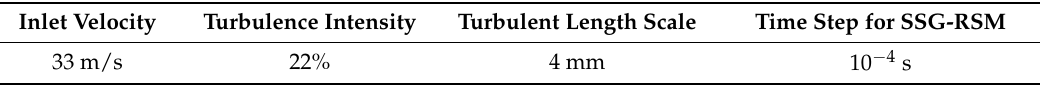
Table 2. Selected inlet boundary conditions. SSG-RSM = Speziale et al. [17] Reynolds Stress Model. Inlet Inlet Velocity